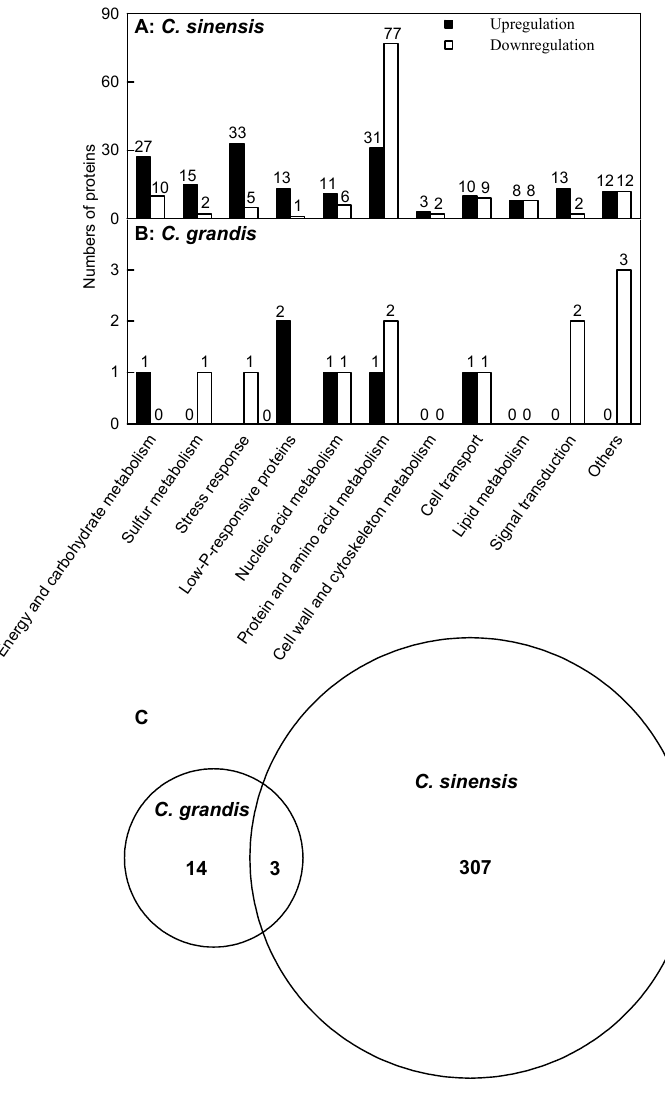
Figure 2. Classification of Al toxicity-responsive proteins in C. sinensis ( A ) and C. grandis ( B ) leaves; and Venn diagram analysis of Al toxicity-responsive proteins ( C